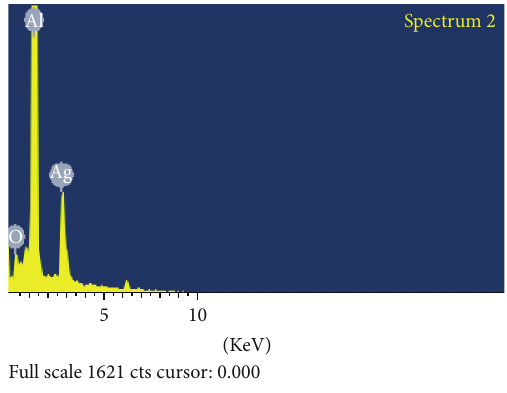
Figure 2: Energy dispersive X-ray spectrum of silver